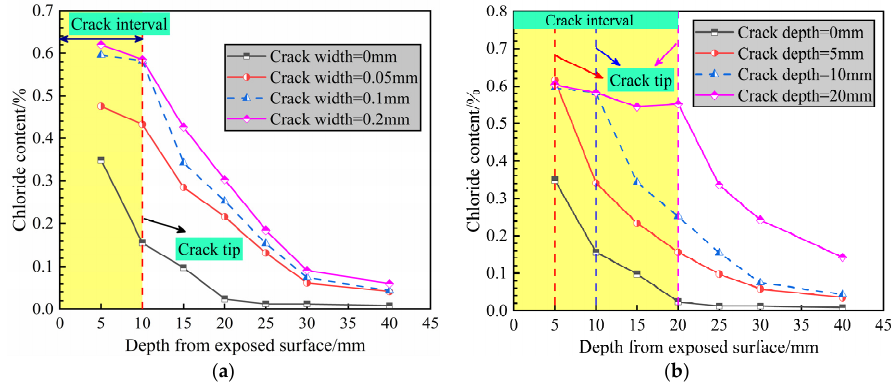
Figure 6. Chloride content depth profiles for concrete specimens with different ( a ) crack widths and ( b ) crack lengths.